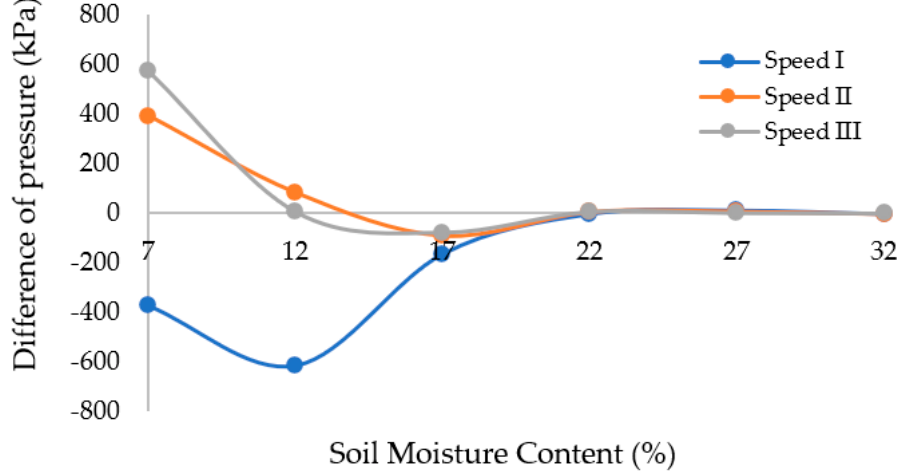
Figure 15. Variation trend of soil reaction force at different penetration speeds.